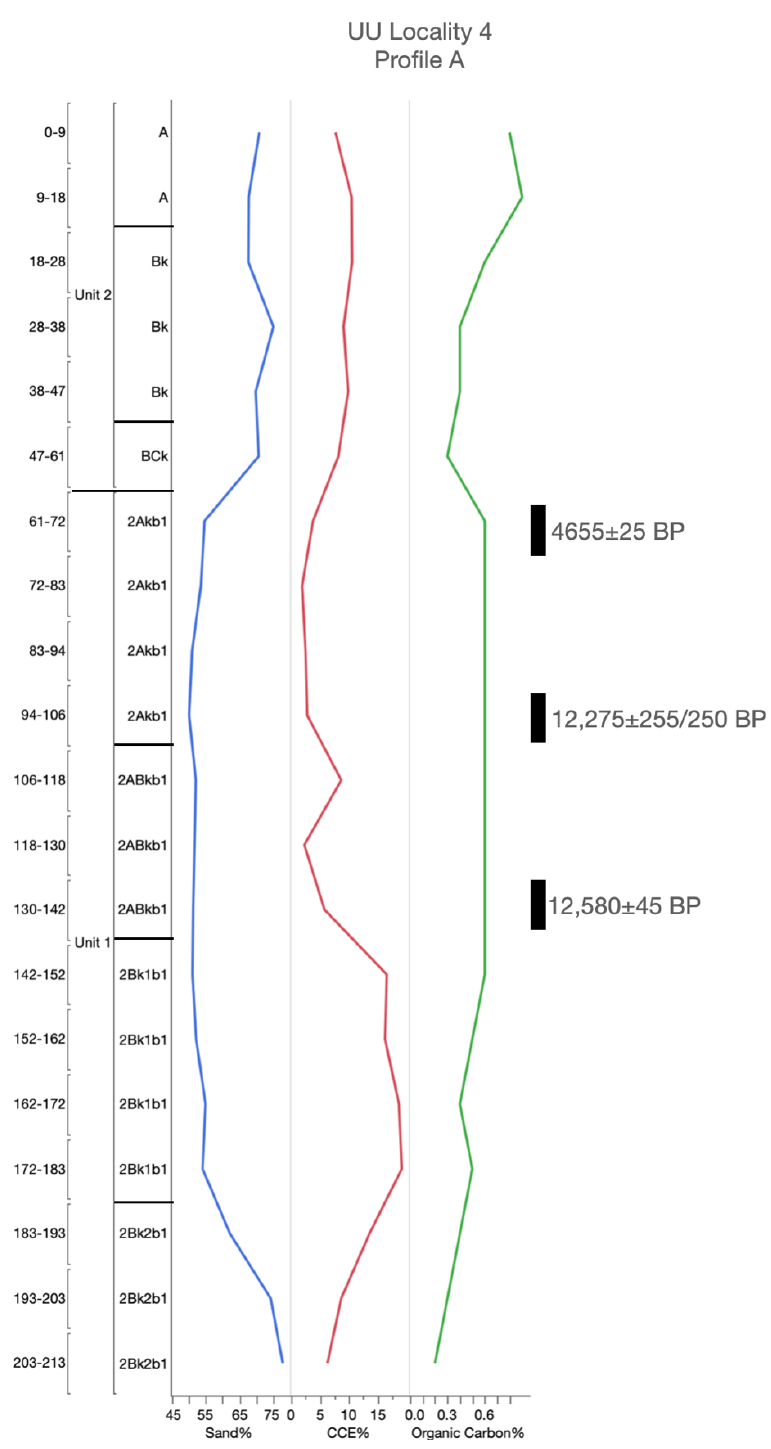
Figure A2. Accepted radiocarbon ages and soil and sediment analysis at UU Locality 4, Profile A—Post research area, northwest, Texas. CCE = calcium carbonate equivalence.